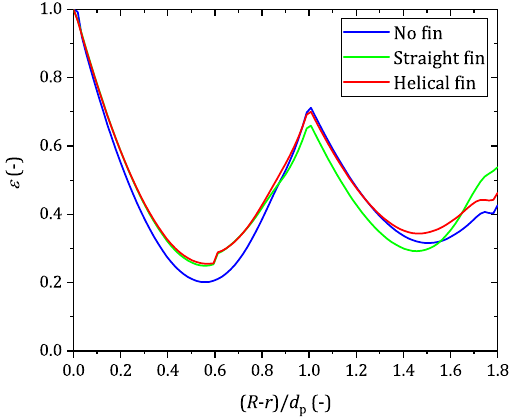
Figure 8. Radial void fraction distribution for the different investigated designs.